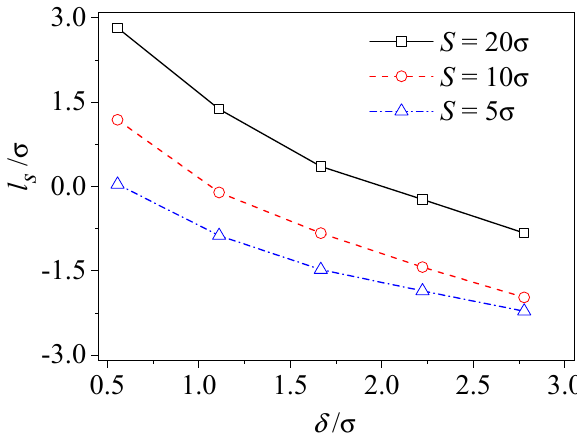
Figure 8. The effect of roughness height and spacing on slip length ( ρ w = 4 ρ , δ = 0.25 σ ).